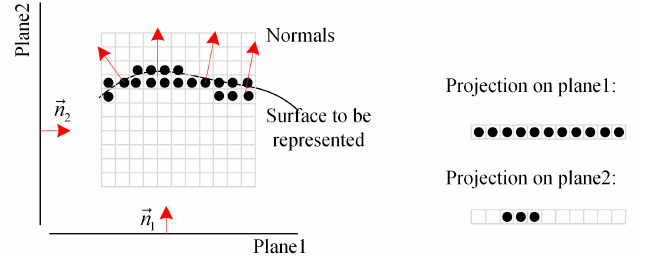
Figure 7. Projection to different planes.